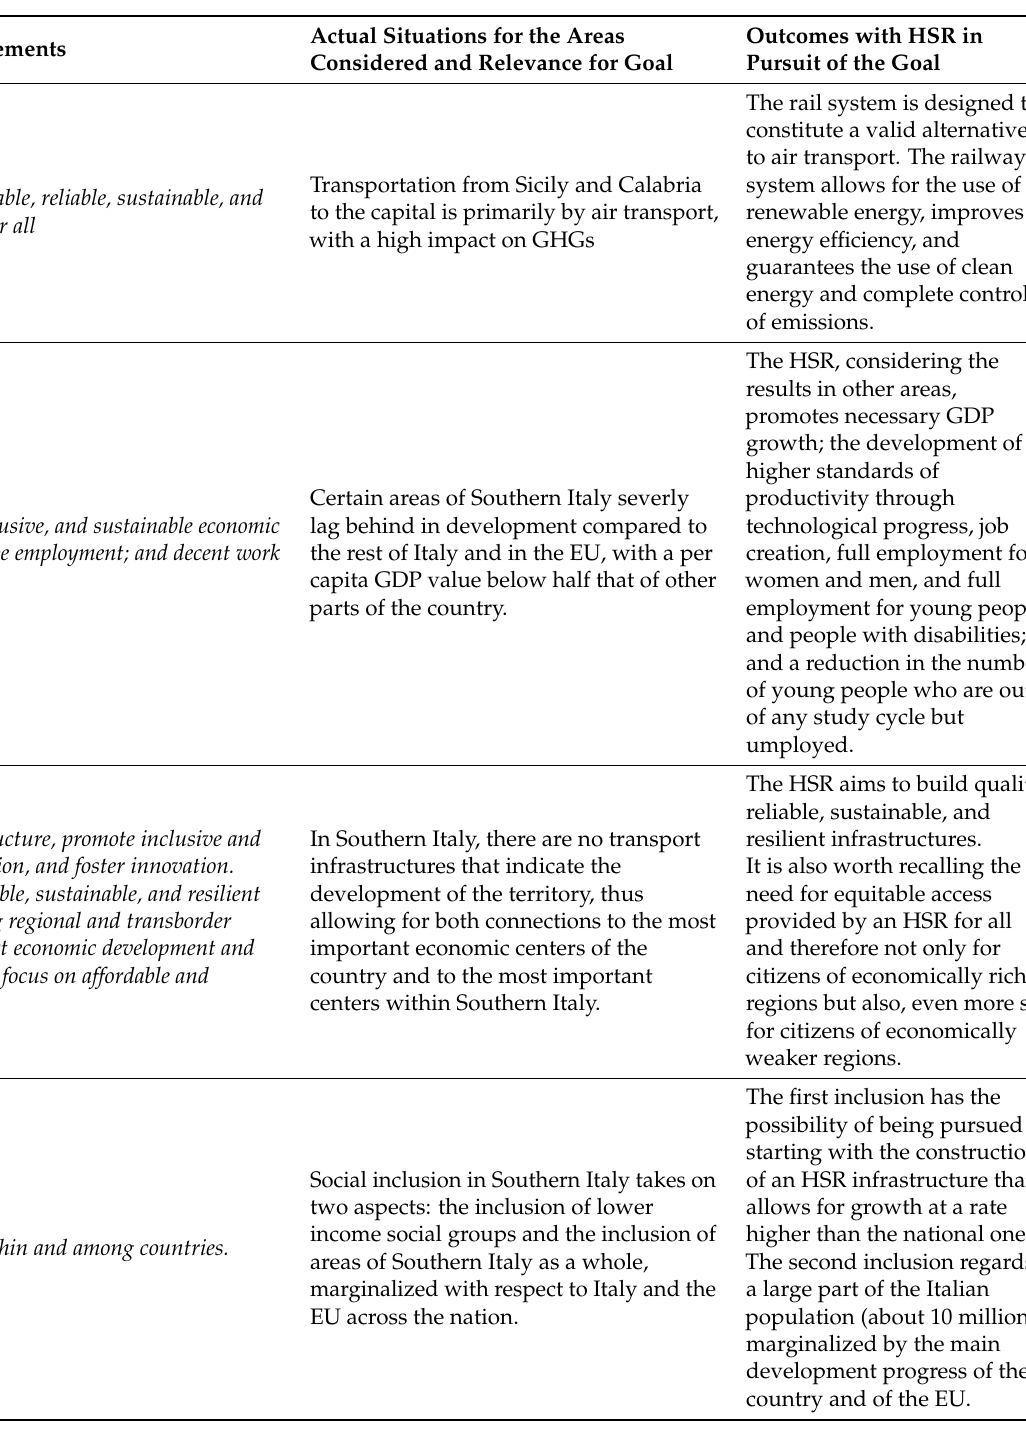
Table 1. International goals, actual situations, and planned